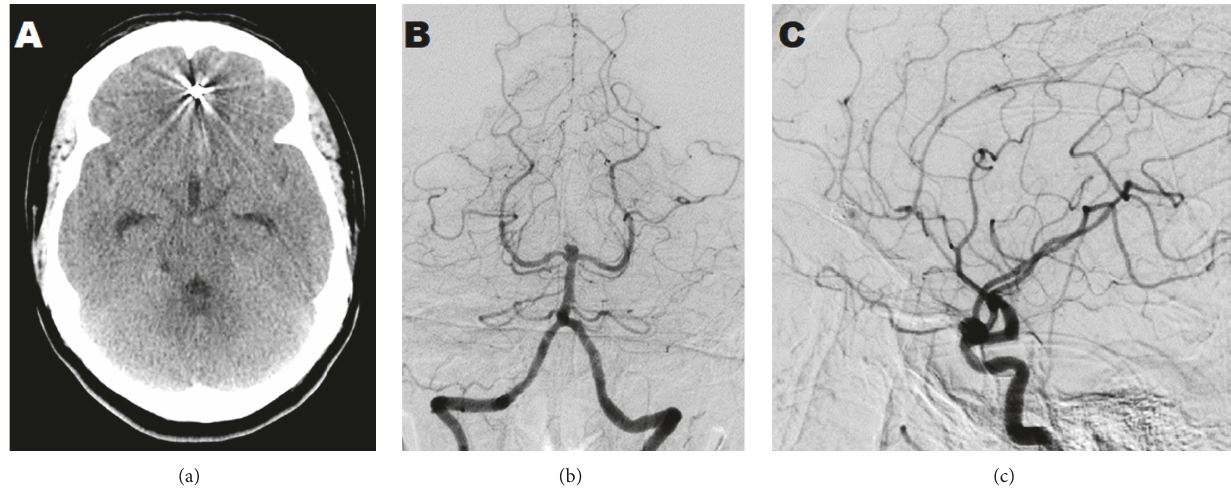
Figure 2: Imaging upon hospitalization in 2016. (a) CT head without contrast in 2016 showing intracerebral hemorrhage adjacent to the previously coiled aneurysm. (b and c) Cerebral angiogram of the anterior and posterior circulations showing the development of multiple new aneurysms.